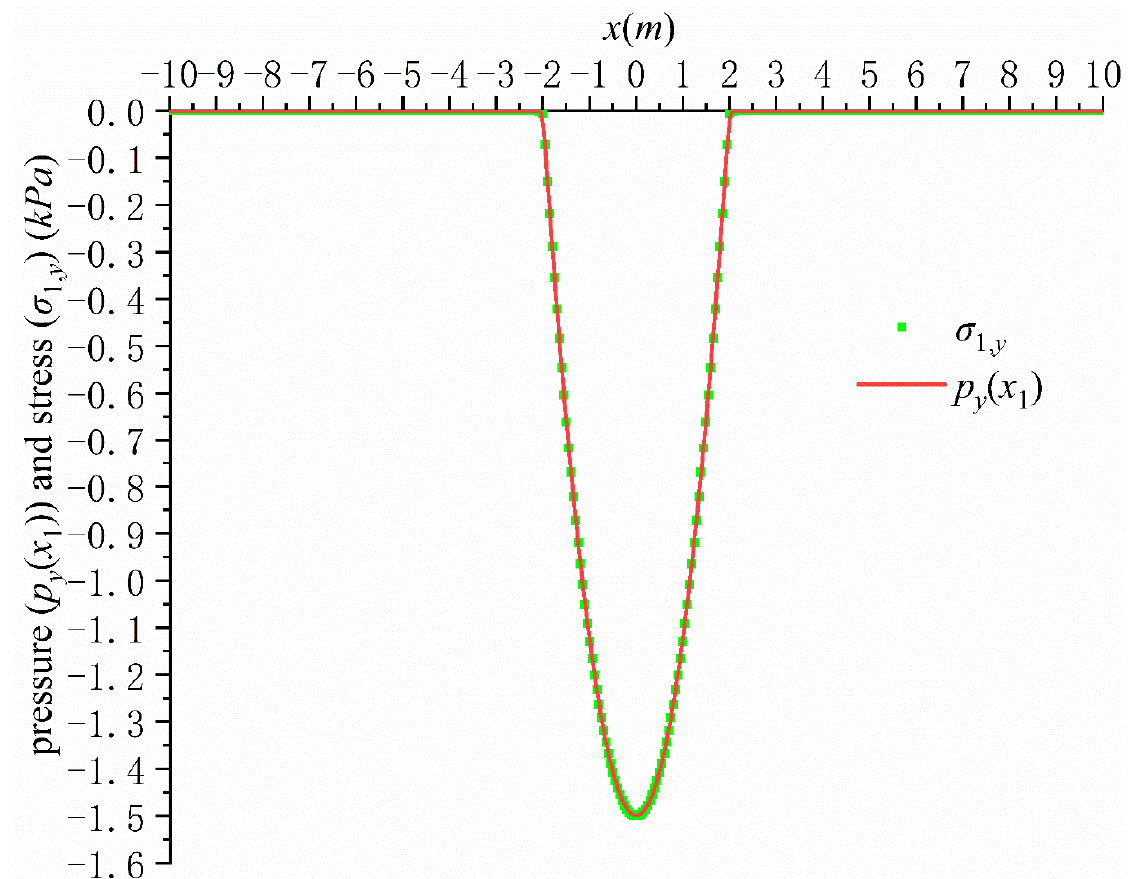
Figure 2. Verification of stress boundary conditions.